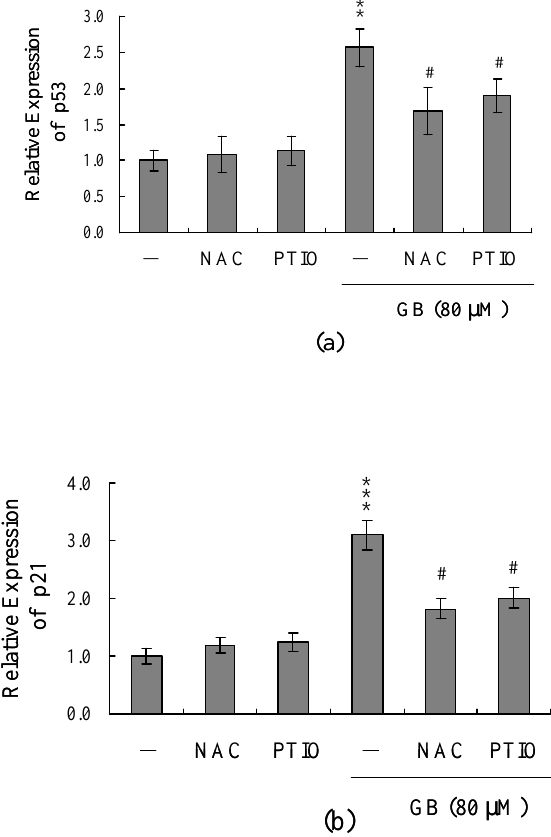
Figure 6. Effect of NAC and PTIO on the mRNA expression levels of p53 and p21. Cells were pre-incubated with or without NAC (300 µ M) and PTIO (20 µ M) for 1 h and then treated with ginkgolide B (80 µ M) for another 24 h. The mRNA expression levels of p53 (A) and p21 (B) were analyzed using real-time PCR. The given values are representative of eight determinations. *** P <0.001 versus the untreated control group. # P <0.001 versus the ginkgolide B-treated